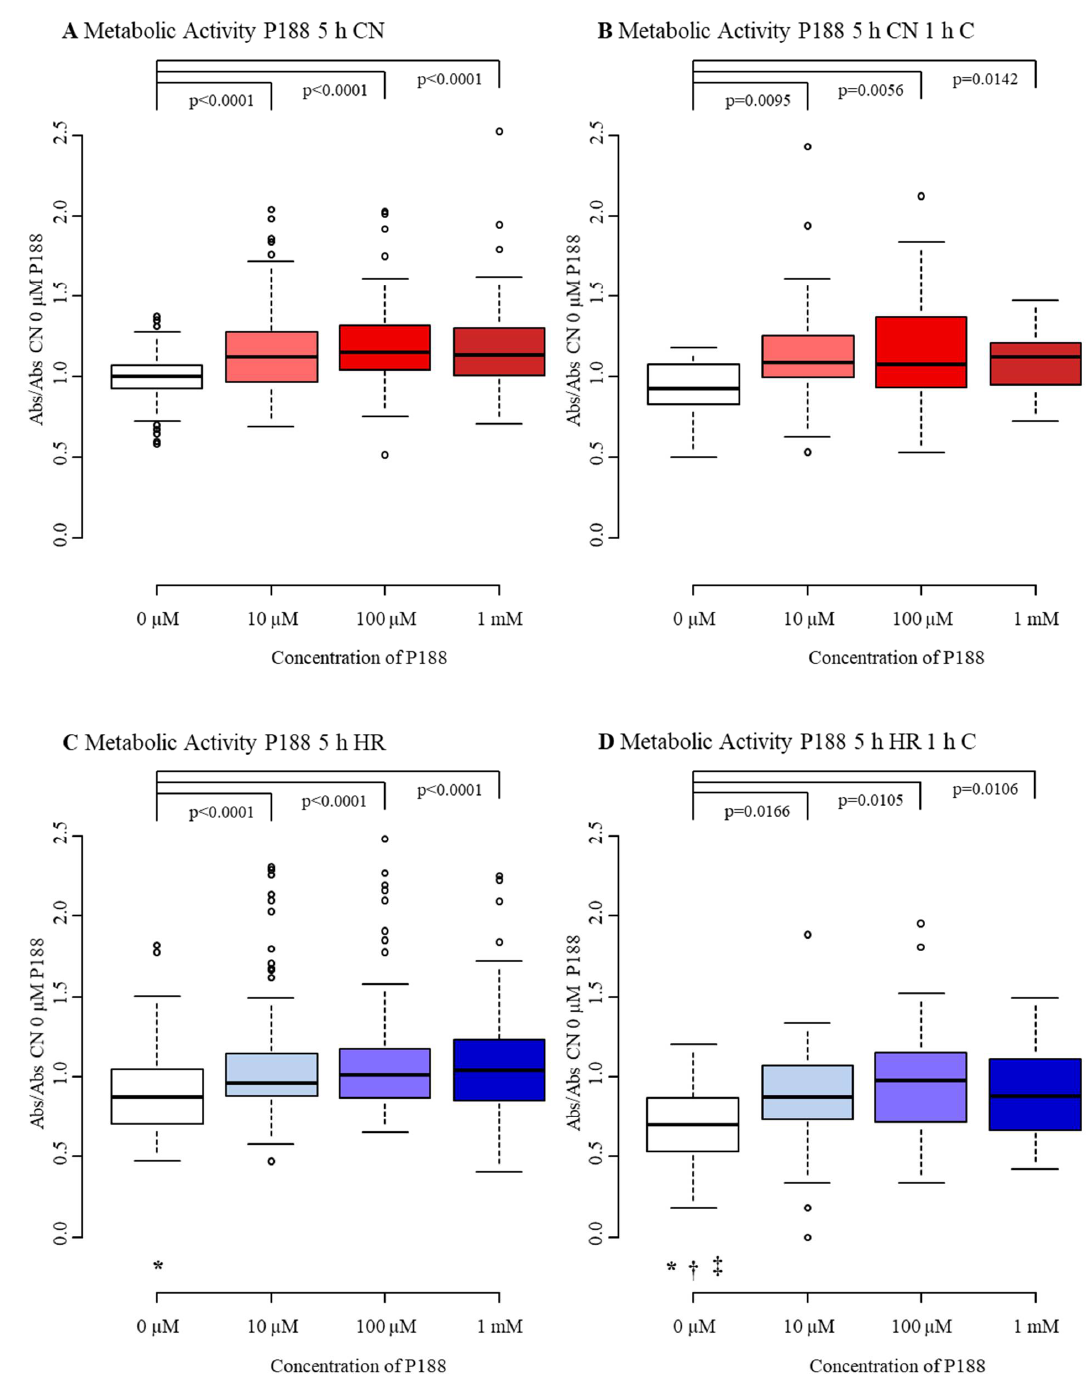
Figure 6. Metabolic activity after 5 h injury and treatment with 0 µ M, 10 µ M, 100 µ M, and 1 mM of P188. ( A ) normoxia (CN-C); ( B ) normoxia and 1 h compression (CN+C); ( C ) hypoxia (HR-C); ( D ) hypoxia and 1 h compression (HR+C). Data visualized as boxplots (median, 25th, 75th percentile, whiskers: minimum, maximum, dots: potential outliers); p < 0.05; n = 10–19 experiments/group. Significances between different concentrations of P188 are displayed as brackets, significances between A, B, C, and D for 0 µ M P188 are represented by symbols (* vs. CN-C 0 µ M P188, † vs. CN+C 0 µ M P188, ‡ vs. HR-C 0 µ M P188). Abbreviations: Abs, absorbance; C, compression; CN, control/normoxia; h, hours; HR, hypoxia/reoxygenation; mM, millimolar; µ M, micromolar; P188, Poloxamer 188. Colors: red, normoxia; blue, hypoxia/reoxygenation. The shadows of red/blue represent the different concentrations of